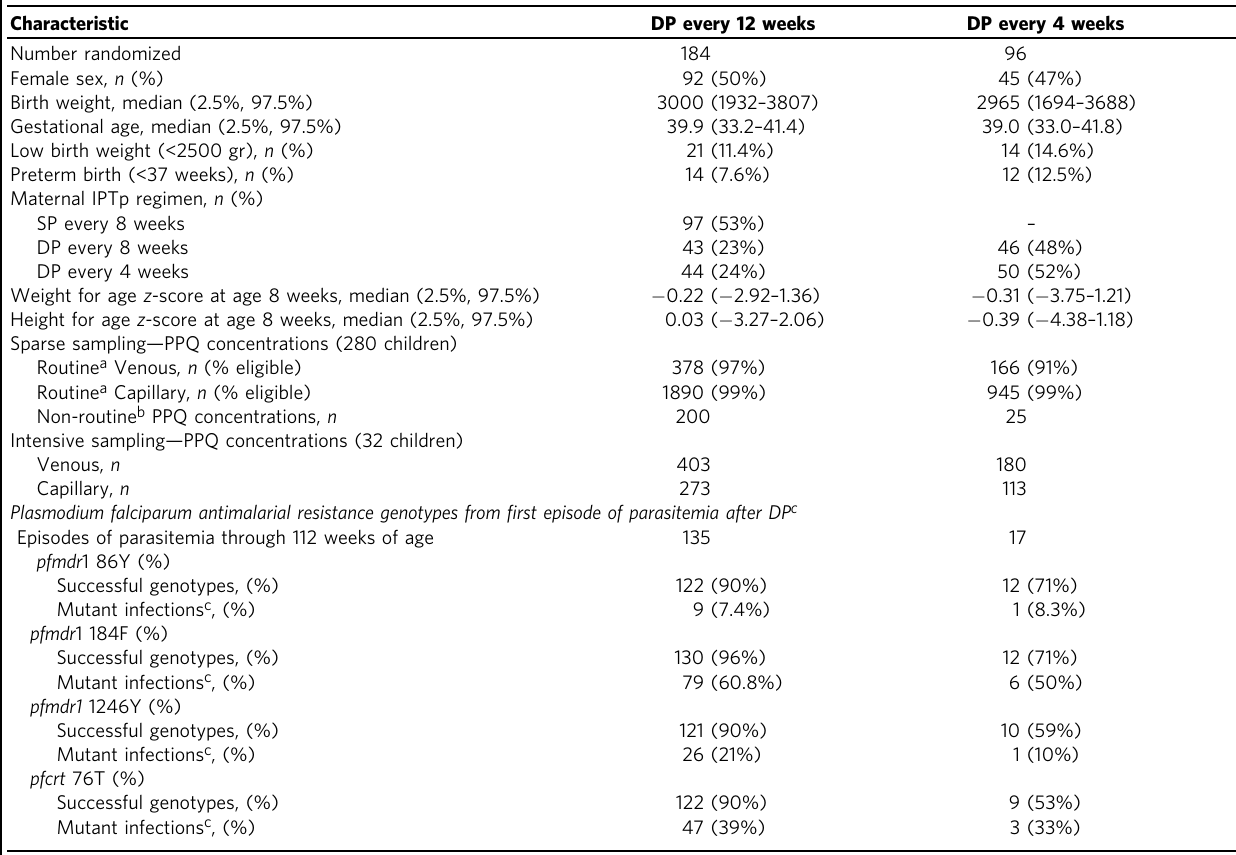
Table 1 Patient